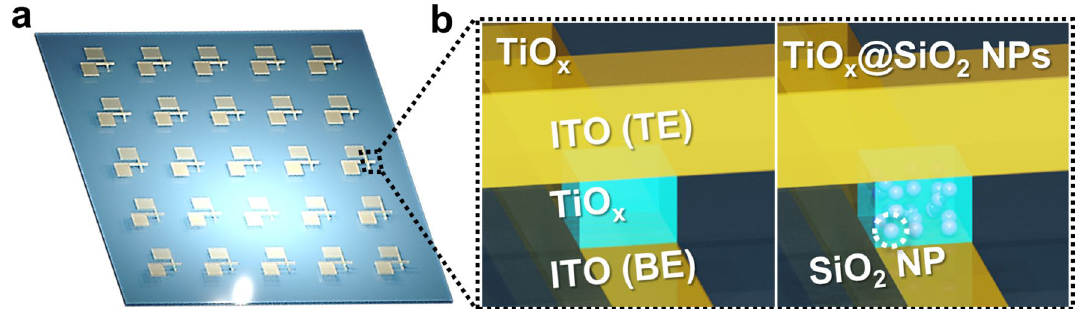
Figure 1. ( a ) Schematic illustration of cross-bar arrays of the TiO x switching device. ( b ) Enlarged view of the cross-section region of the switching device unit